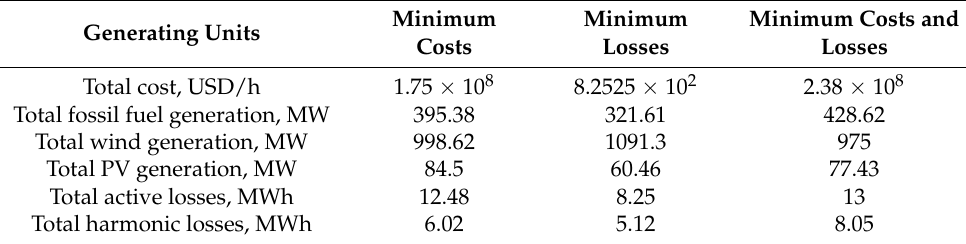
Table 5. Summary of the costs, generation, and losses for the three scenarios for Garver